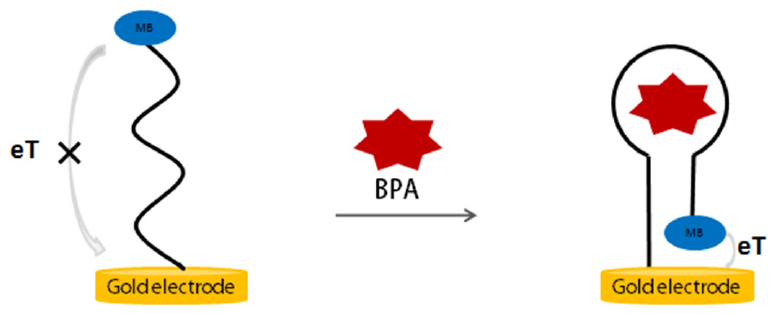
Figure 4. The principle of aptamer-based electrochemical switch sensors for BPA detection.